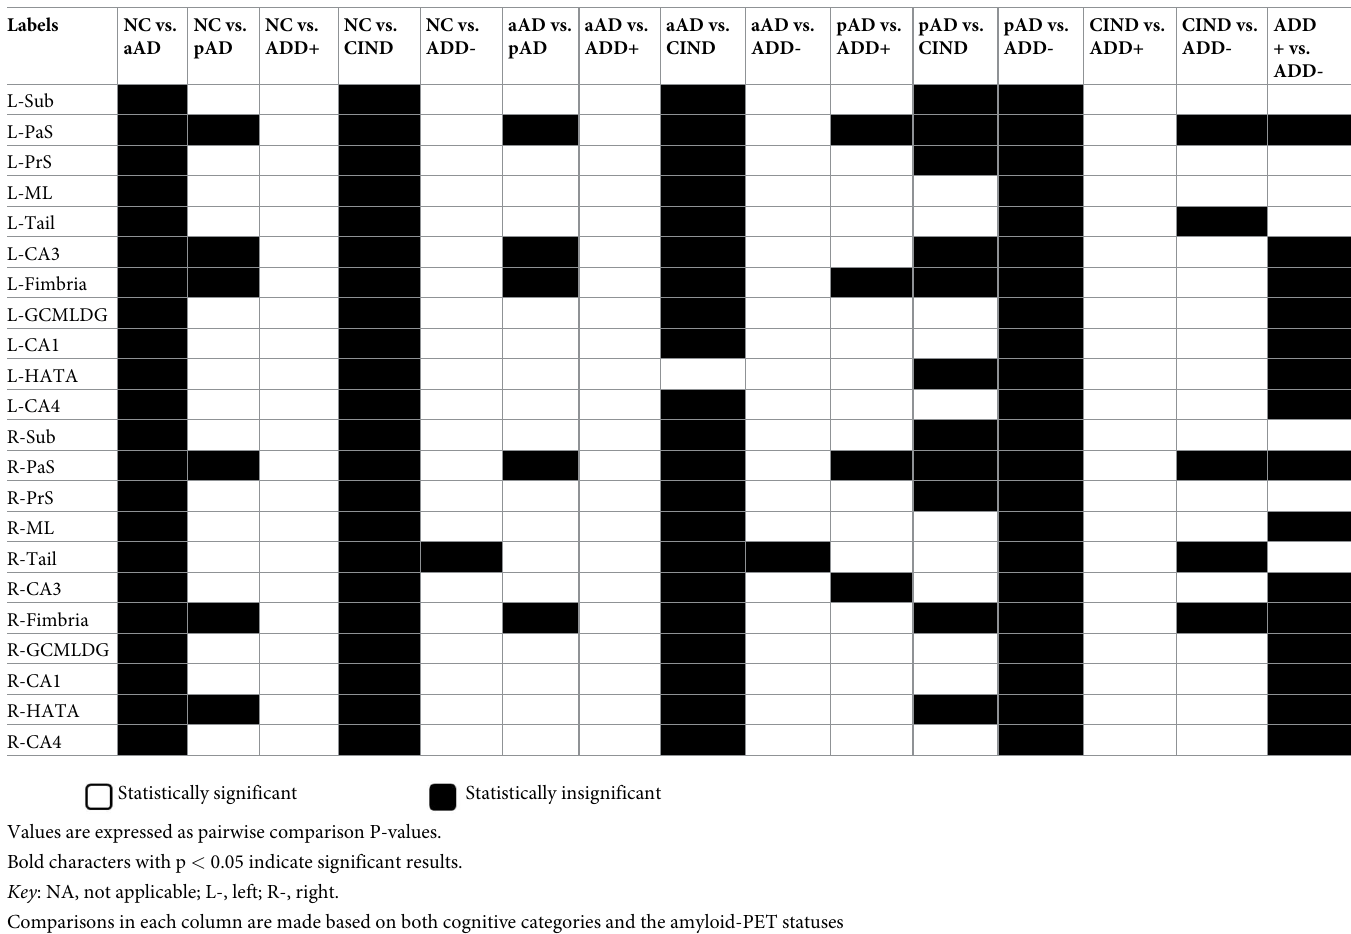
Table 3. Bonferroni pairwise post hoc